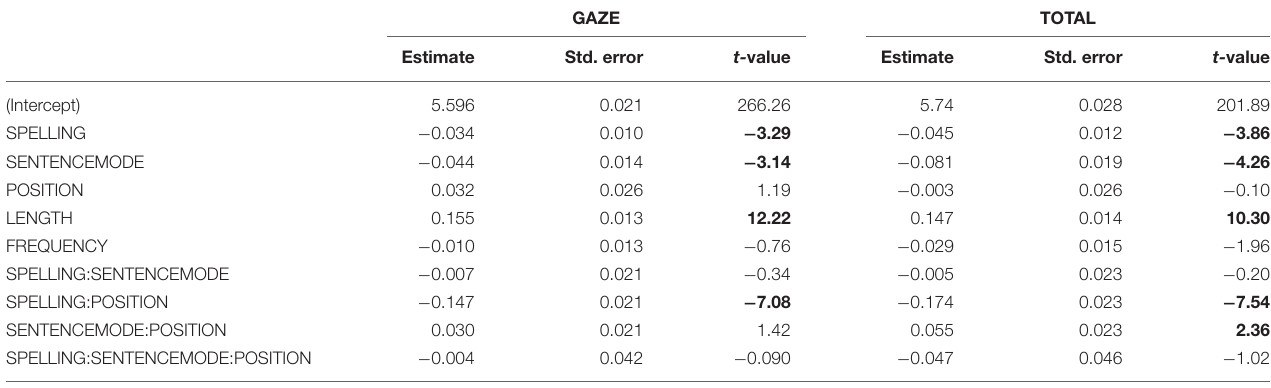
TABLE 2 | Gaze and Total, model data for the independent variables of the fixation duration.